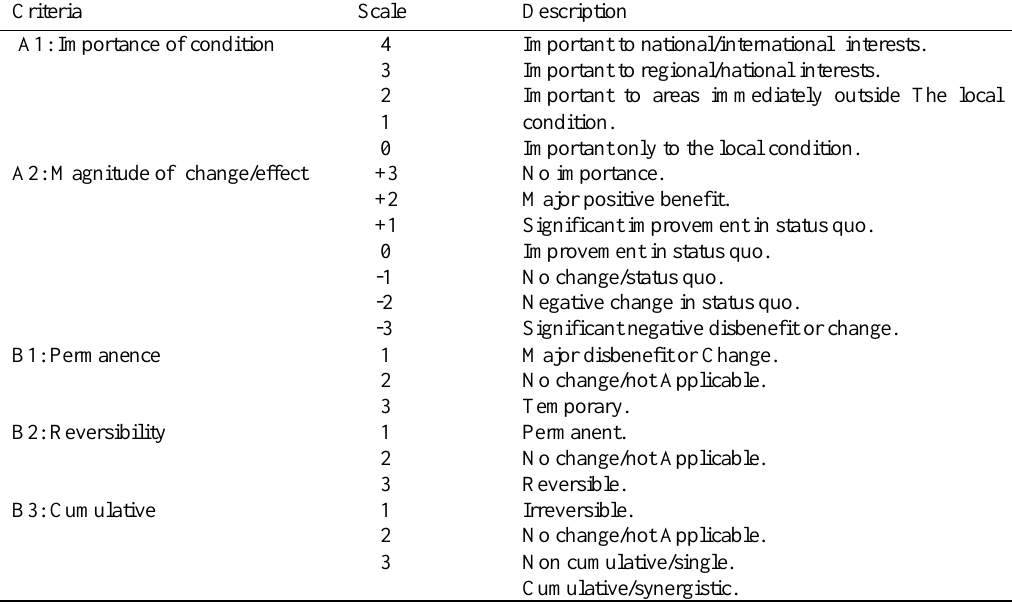
Table 1. Assessment criteria (Pastakia, 1998; Pastakia and Jensen, 1998). Criteria Scale